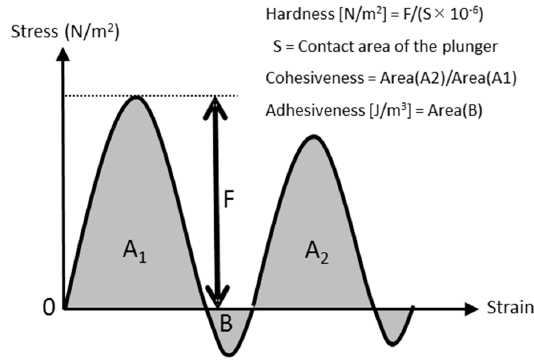
Figure 2. Texture analysis for hardness, cohesiveness, and adhesiveness of materials.